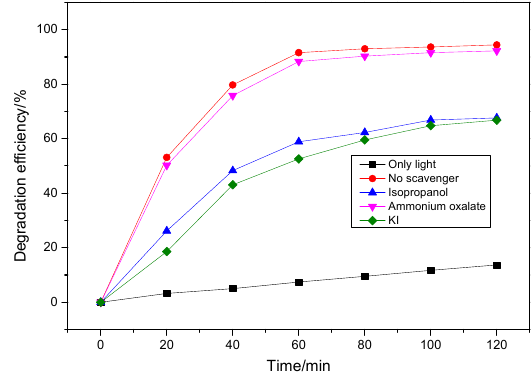
Figure 7. The effect of a series of scavengers on the photocatalytic efficiency of 0.50% Yb/TiO 2 . The BHA concentration was 30 mg/L, the catalyst dosage was 0.5 g/L, and the concentration of all scavengers was 10 mmol/L. Int. J. Environ. Res. Public Health 2017 , 14 , 1471